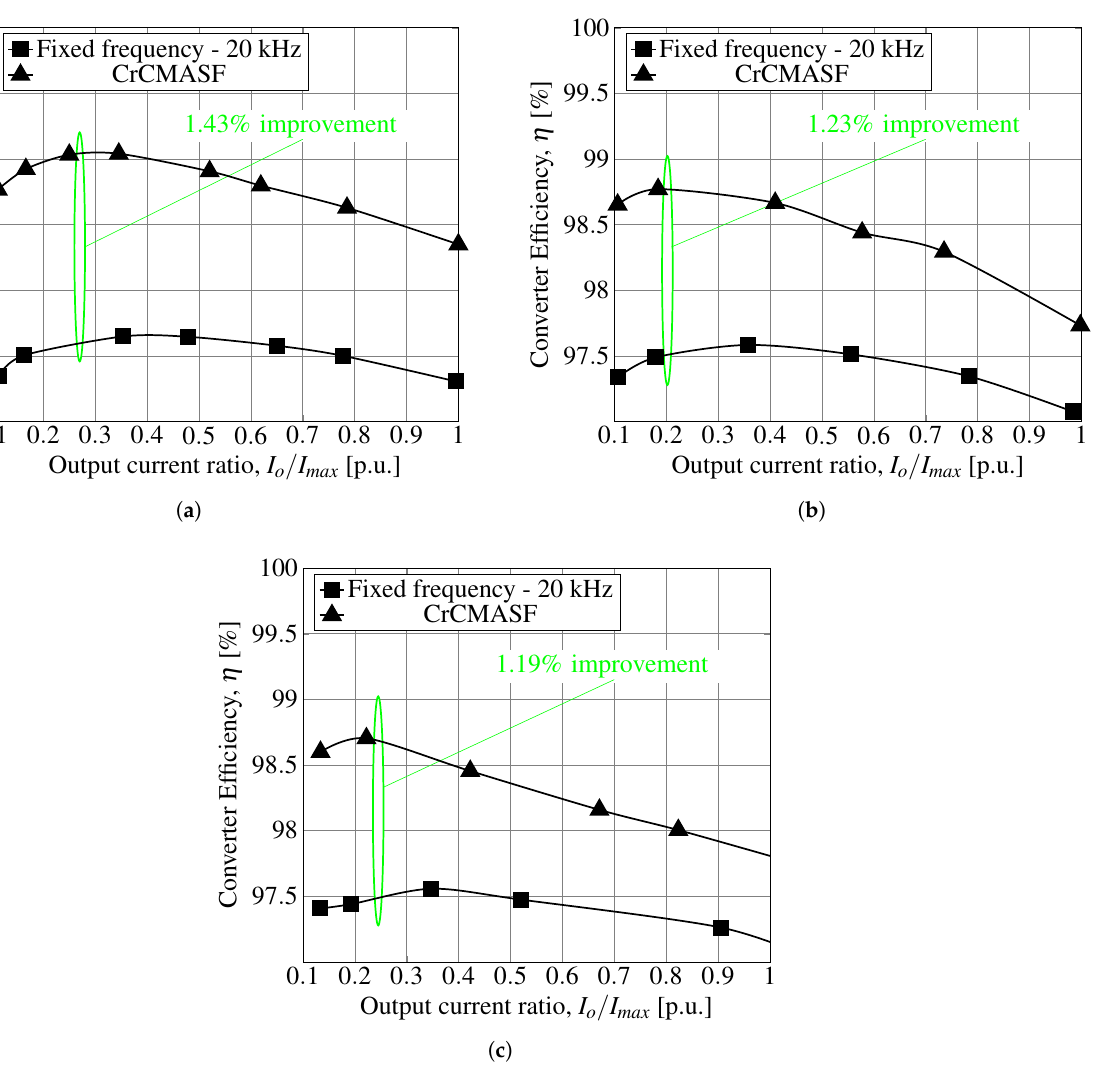
Figure 16. Converter efficiency for a duty cycle of 0.95 and an input voltage of 330 V for different output voltages: ( a ) converter efficiency for an output voltage of 330 V; ( b ) converter efficiency for an output voltage of 315 V; ( c ) converter efficiency for an output voltage of 363